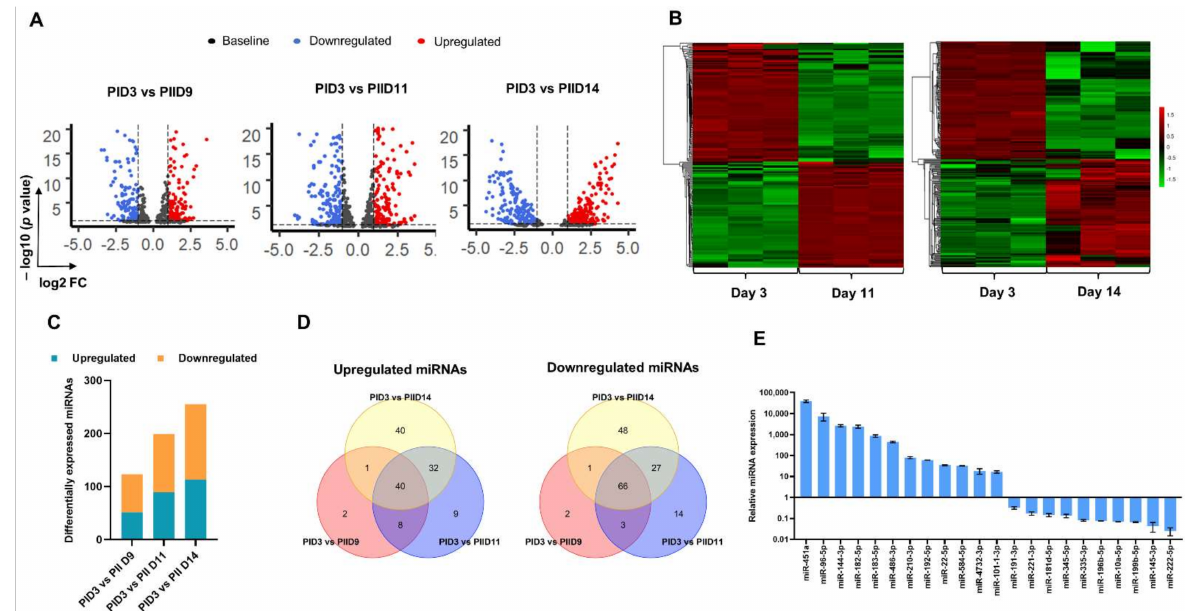
Figure 2. Differential expression of miRNAs at different stages of erythropoiesis. ( A ) Volcano plots showing the differential expression of miRNAs between HPSCs from Day 3 of Phase I of the culture (PID3) and the erythroid cells from Day 9 (PIID9), Day 11 (PIID11), and Day 14 (PIID14) of Phase II of the culture. The log2FC of the miRNAs were plotted against the –log10 of the p values. ( B ) Heatmaps of the normalized miRNA reads between PID3 and PIID11 and PID3 and PIID14. The reads from triplicates are shown (R1, R2, and R3). ( C ) The total number of miRNAs with significant differential expression (log2FC > 2 or < − 2, p < 0.01). ( D ) Upregulated and downregulated miRNAs (log2FC > 2 or < − 2, p < 0.01) in the cells from different time points of ex-vivo erythropoiesis. ( E ) Validation of the differential expression of miRNAs by quantitative real-time PCR. Table 1. miRNAs with significant differential expression during erythropoiesis (log2FC > 5 or < − 5, p < 0.01). log2FC miRNA Total Reads PID3 vs. PIID9 PID3 vs. PIID11 PID3 vs. PIID14 728